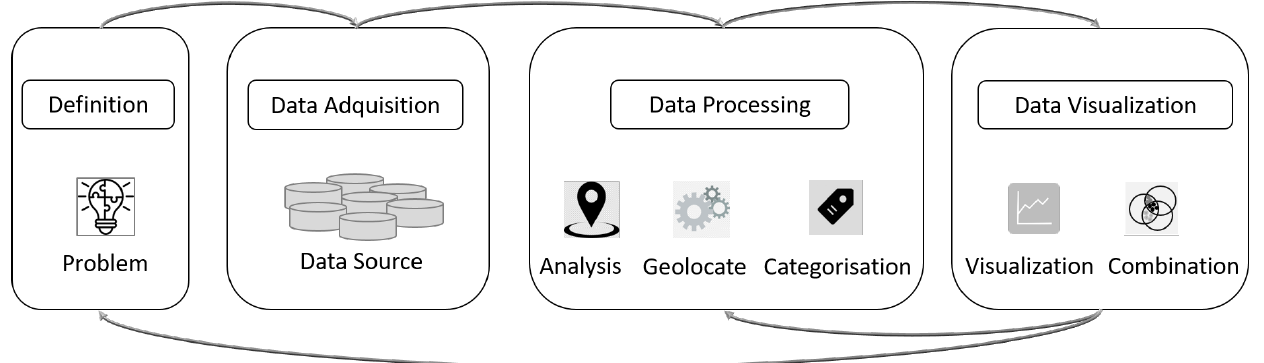
Figure 1. Description of the phases of the intrinsic methodology of the COVIDSensing